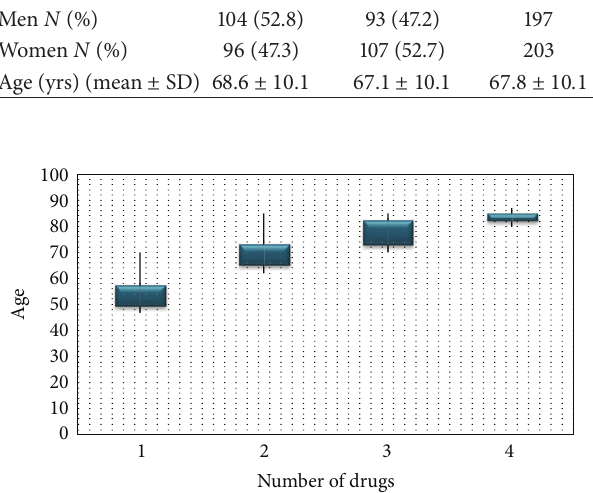
Figure 1: Box-plot distribution between age of the subjects and number of anti-IOP